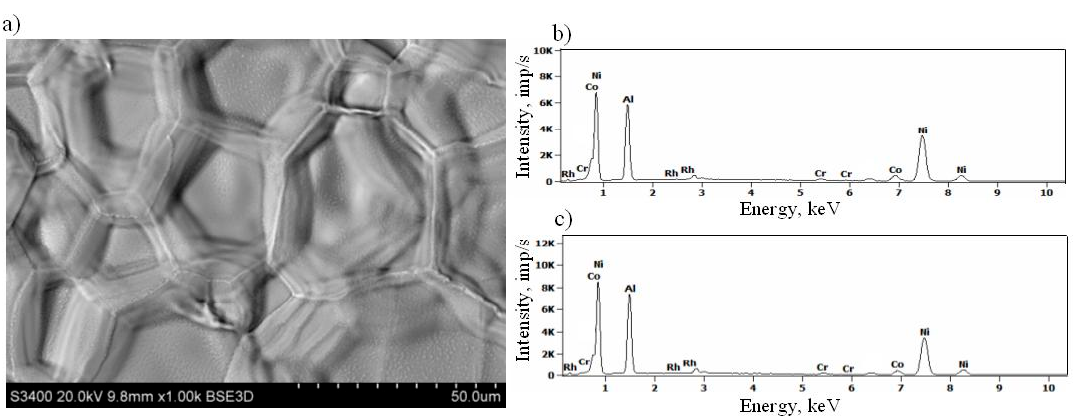
5 of 11 Figure 3. X-ray diffraction (XRD) patterns of the nonmodified ( a ), rhodium-modified ( b ) and rhodium- and hafnium-modified ( c ) aluminide coatings. Figure 4. XRD shifts of the NiAl (100) reflection of the nonmodified ( a ), rhodium-modified ( b ) and rhodium- and hafnium-modified ( c ) aluminide coatings. 3.2. Rhodium-Modified Aluminide Coatings (b) The surface of the rhodium-modified aluminide coating consists of polyhedral-shaped grains, similar to the nonmodified coating (a) (Figure 5a). Grain size on the surface is about 19–38 μ m. The core and grain boundary consist of nickel, aluminum, cobalt, and chromium. Moreover, some rhodium peaks are visible (Figure 5b,c). The overall surface composition is 49.8Al–45.8Ni–0.7Cr– 3.7Co (atom %). The rhodium content on the surface of the coating is smaller than 0.1 wt %. Such a chemical composition indicates that the rhodium-doped β -NiAl phase has formed. Microstructure analysis on the cross-section showed that the coating is composed of two layers: an additive layer and an interdiffusion layer (Figure 6a), like the nonmodified one (a). The total coating’s thickness is